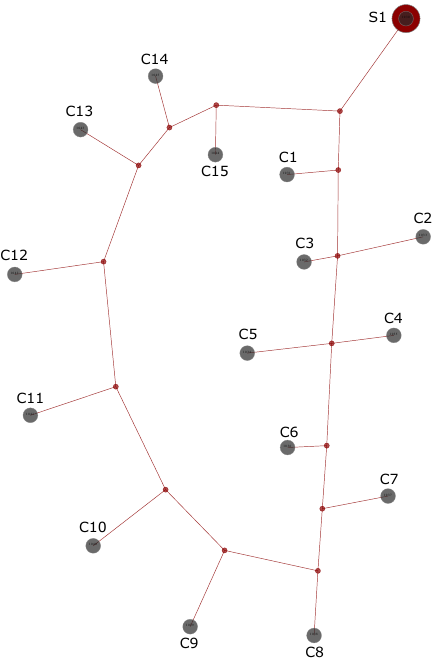
Figure 13. Representation of the graph after network simplification. To supply the buildings with heating and cooling energy, a 5GDHC network with a total pipe length of 11.5 km is planned. The network is designed as a non-directed bidi- rectional low-temperature network, which is simultaneously used to supply the buildings with heat and cold. Therefore, the thermal network has warm and cold lines which are both operated at temperatures close to the ambient temperature. Decentralized heat pumps are used at the substations of each cluster, which raise the low network temperatures to the temperature level required in the buildings. The load profiles of the buildings for space heating and cooling are generated using dynamic building simulations. For this purpose, models of the Modelica library AixLib [34] were used, which are parameterized